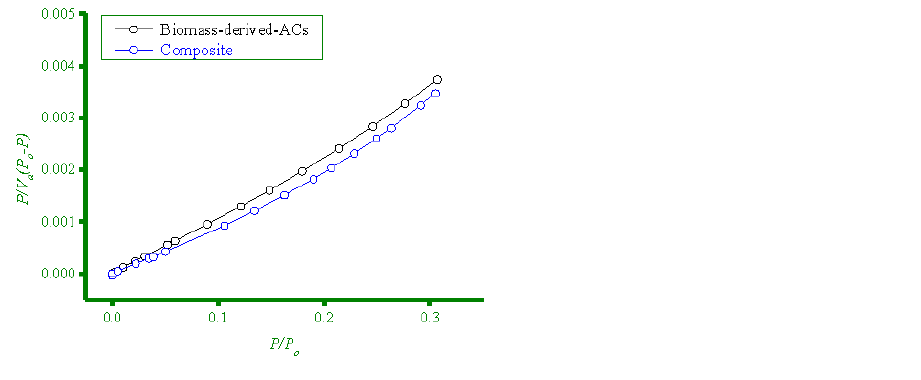
Figure 5. Nitrogen adsorption-desorption isotherms for biomass-derived-ACs, and the Fe 3 O 4 -carbon-based composite at 77.36 K.